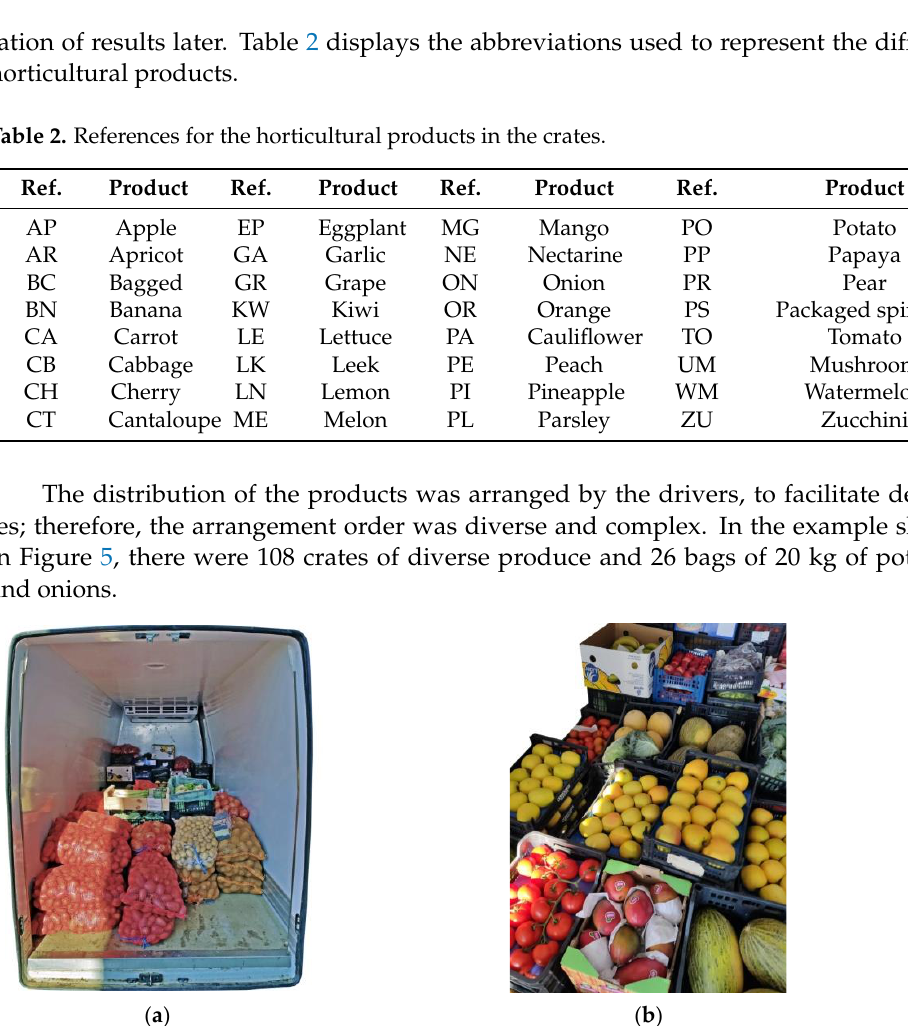
Figure 7. Organization of crates among the cargo area and sensor distribution. 2.4. Route and Stops The route consisted of the distribution of an assortment of horticultural products, along with five different local retail stores within the northern region of Castelo Branco, Portugal. The measurements were taken during the month of June, in the beginning of the Portuguese summer season, with the temperatures within the minimum average of 15.1 °C and maximum average of 29.4 °C, reaching a maximum absolute value of 38.5 °C [42]. Figure 8 displays a map of the route along with the stops and a graphical representation of the duration of those stops. This graphical representation was overlayed with the sen- sor data in the results section of the present work, so that the context of the stops could be taken into consideration while analyzing the results.